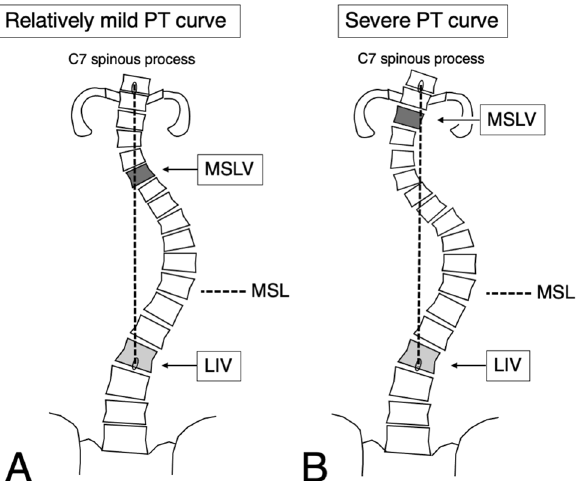
Figure 1. The MSL is the line connecting the center of the spinous process of C7 with that of the LIV. The vertebral body first touching the MSL proximally is defined as the MSLV. ( A ) A relatively mild PT curve. ( B ) For severe PT curves, the line may deviate from the vertebral column, in which case we redefined the MSLV as the most proximal vertebral body first touching the MSL. PT proximal thoracic, LIV lowest instrumented vertebra, UIV upper instrumented vertebra, MSL modified Shinshu line, MSLV MSL